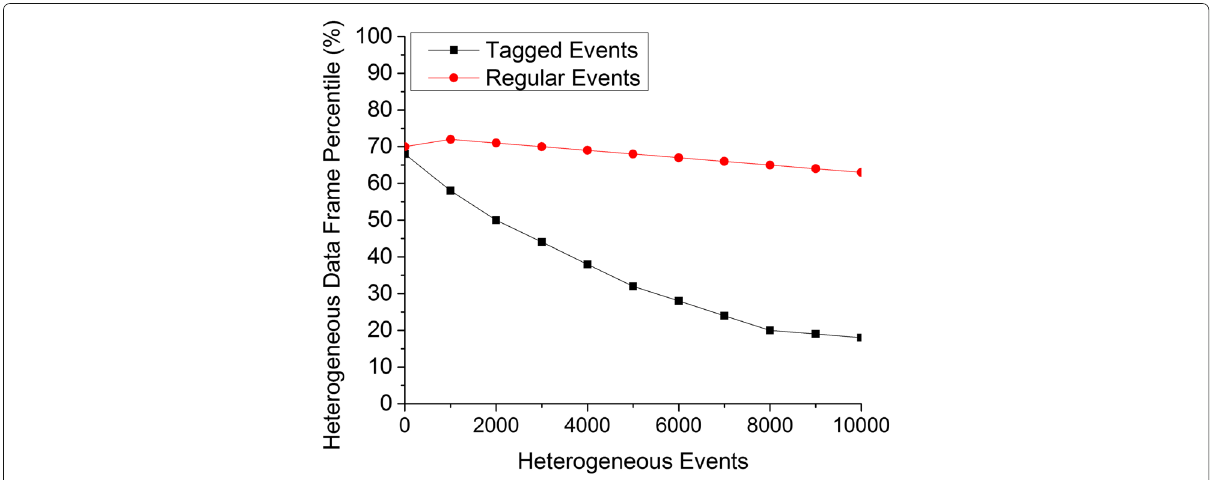
Fig. 10 Heterogeneous Data Frame Computing Percentile